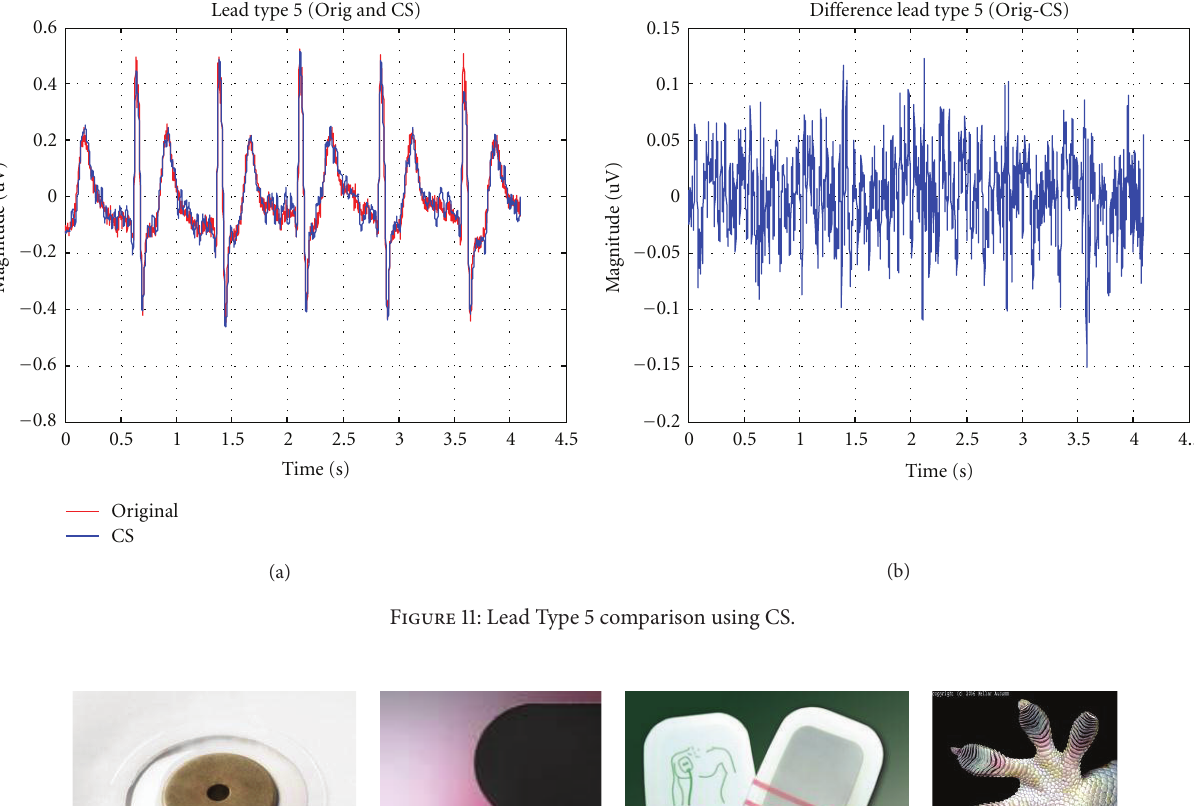
Figure 11: Lead Type 5 comparison using CS.